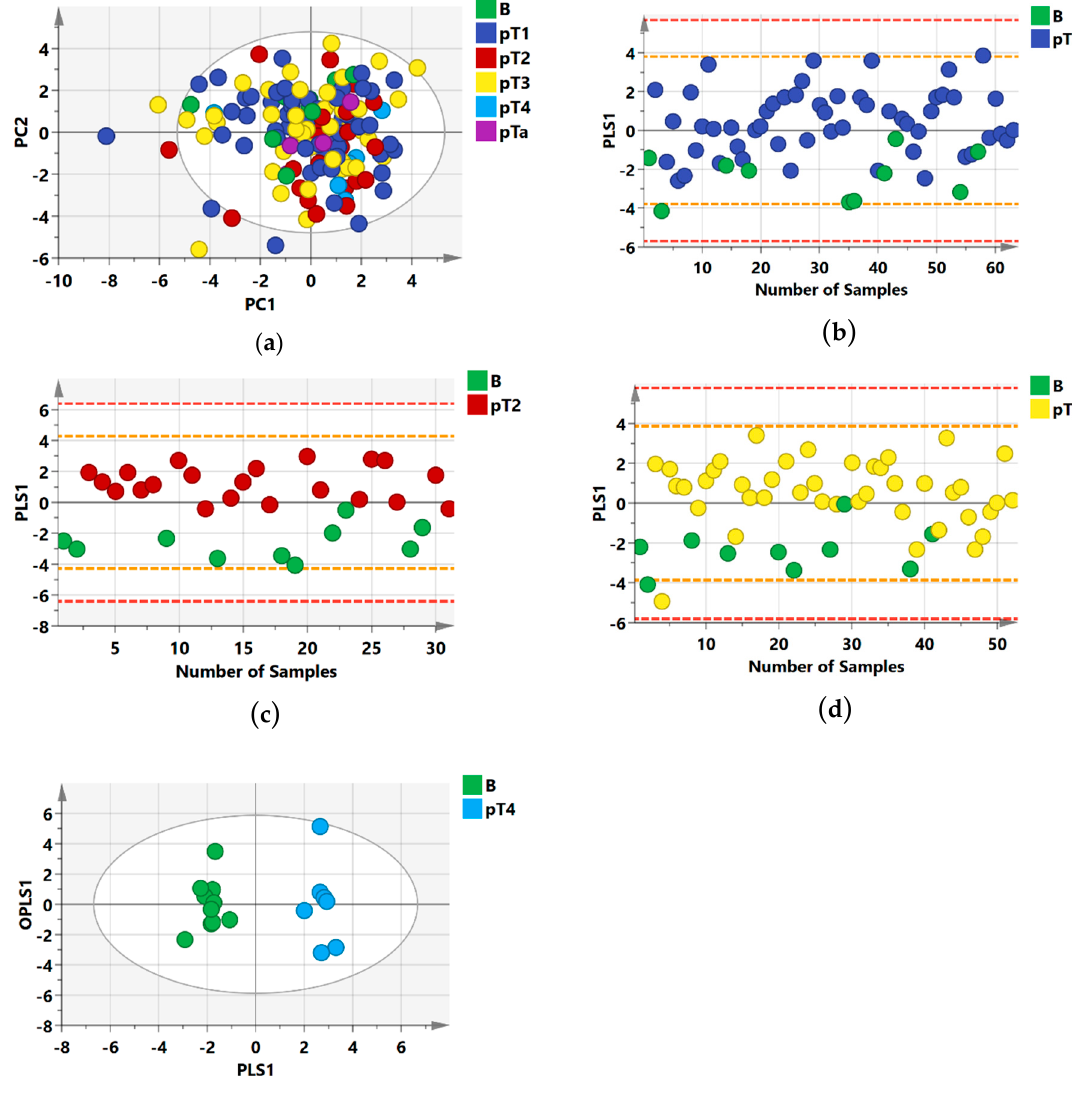
Figure 1. NMR Statistical Models showing separation between benign lesions and combined histological subtypes in supervised models ( a ) Principal Component Analysis; PCA-X scatter score plot, ( b ) Orthogonal Partial Least Squares Discriminant Analysis (OPLS-DA) scatter score plot benign versus stage 1 cancer cases; ( c ) benign versus stage 2 cancer cases ( d ) benign versus stage 3 cancer cases ( e ) benign versus stage 4 cancer cases; along their orthogonal partial least squares (OPLS1) and partial least squares components (PLS1). The white spheres in ( a ) and ( e ) describe the 95% confidence interval of the Hotelling’s T-squared distribution and the orange and red dashed lines in ( b – d ) describe the 2SD and 3SD limits respectively.